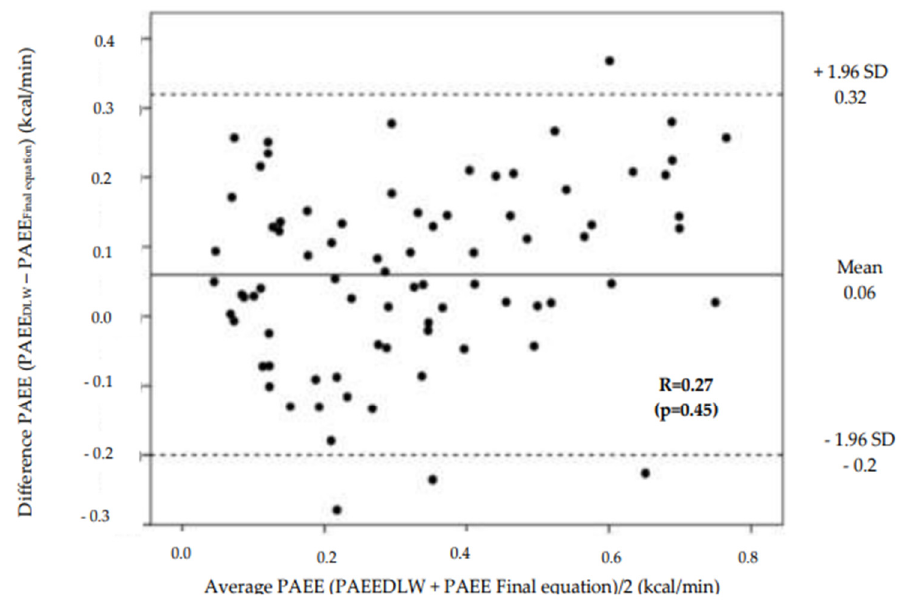
Figure 2. Bland–Altman plots showing bias and average between the PAEE calculated using the criterion method (DLW) and estimated using the final equation. The mid-line indicates the mean bias and the two dashed lines, the upper and lower agreement limits (mean bias ± 1.96 x standard deviations,